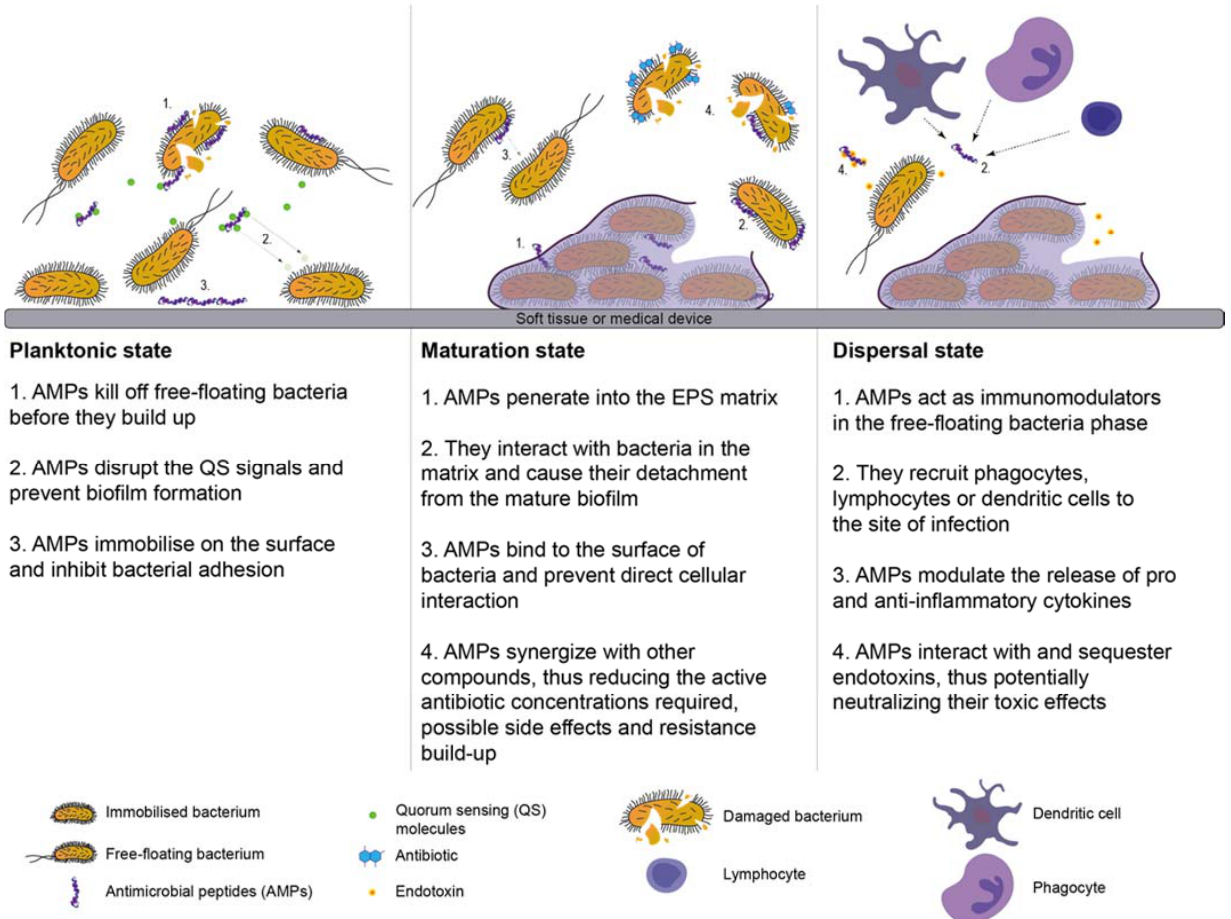
Figure 4. The three main steps of the biofilm life-cycle (attachment to a surface, maturation, and dispersal) and the mechanisms exhibited by Antimicrobial peptides (AMPs) in every step .